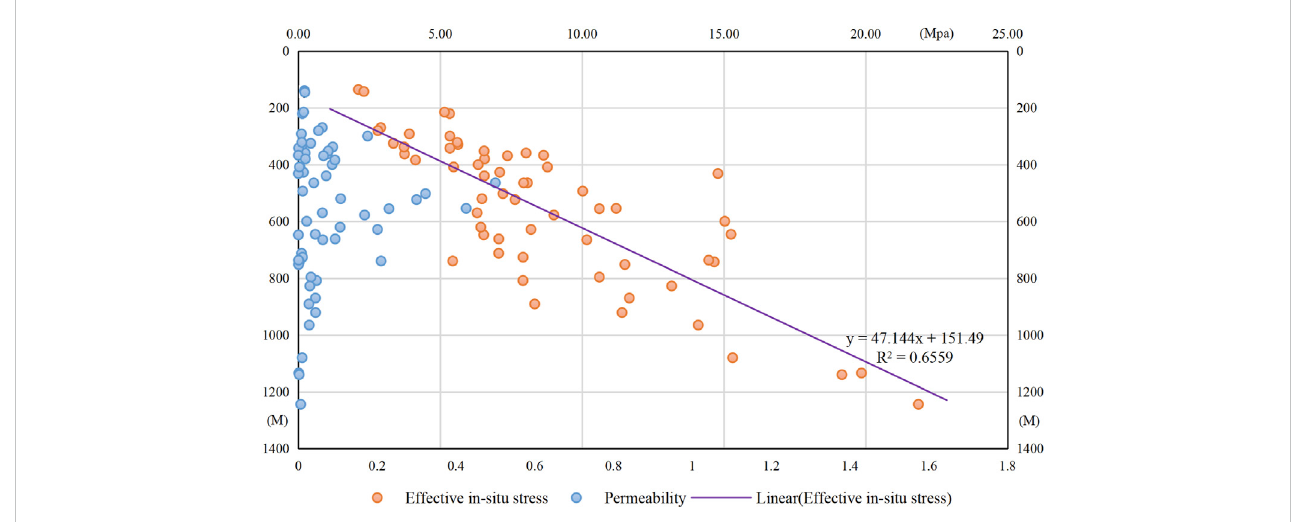
FIGURE 11 Relationship between reservoir EIS and permeability in western